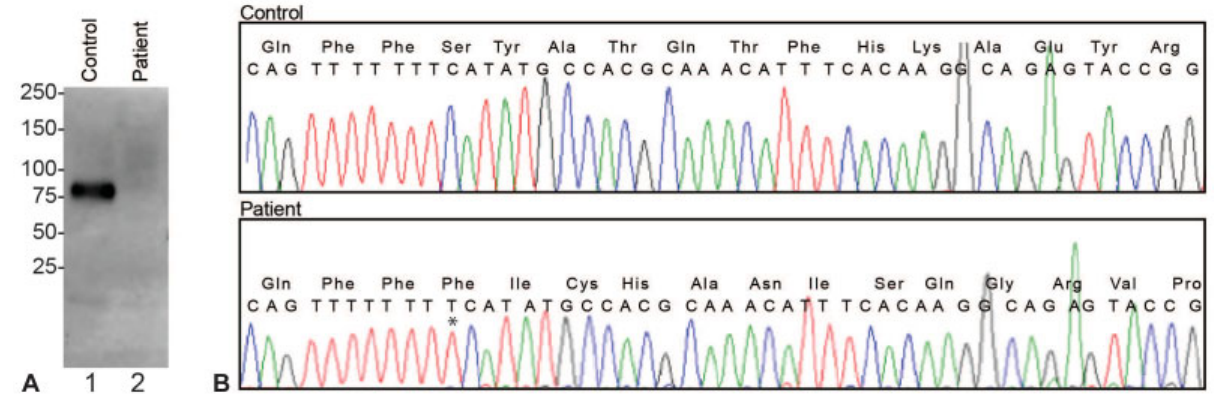
Fig.1. Mutation in prekallikrein gene. ( A ) Immunoblotof plasma. Two microliter ofcontrol andpatient was electrophoresedand blotted withan antibody to plasma prekallikrein (clone 13G11 from Invitrogen). ( B ) Sequencing traces of PCR ampli fi ed exon 5 depicting the homozygous single nucleotide ( (cid:1) ) insertion in codon 132, leading to frameshift all of subsequent codons. PCR, polymerase chain reaction.